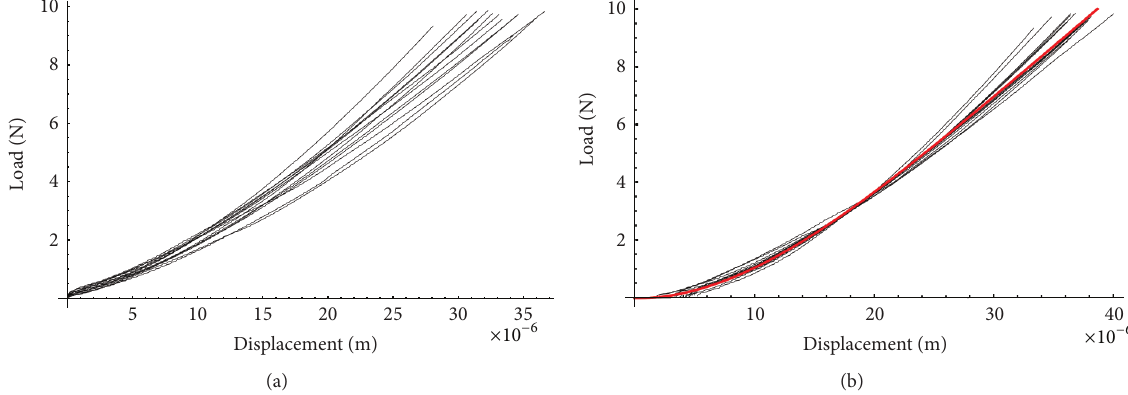
Figure 2: Raw curves for the Al-Sn alloy (a) and corrected data (b), with the fitting curve plotted in red.